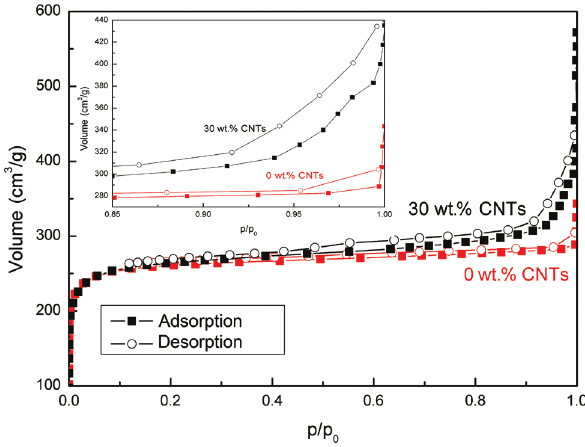
Figure 7 Effect of CNT ratio on pore size distribution of the compos- ite spheres (activated at 850 ° C).